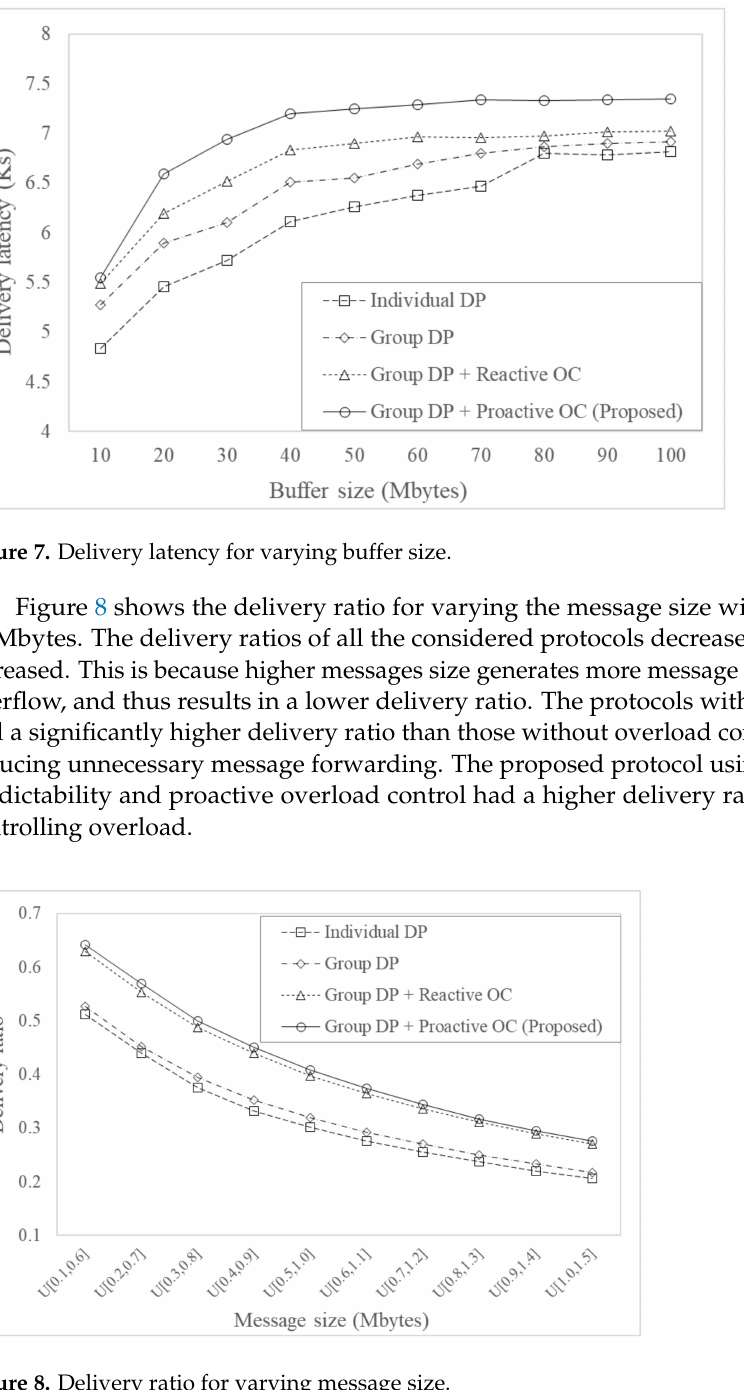
Figure 8. Delivery ratio for varying message